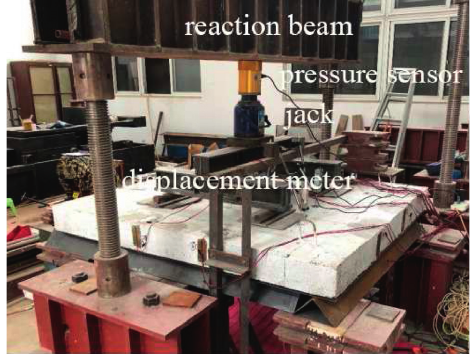
Figure 4: Field diagram of test